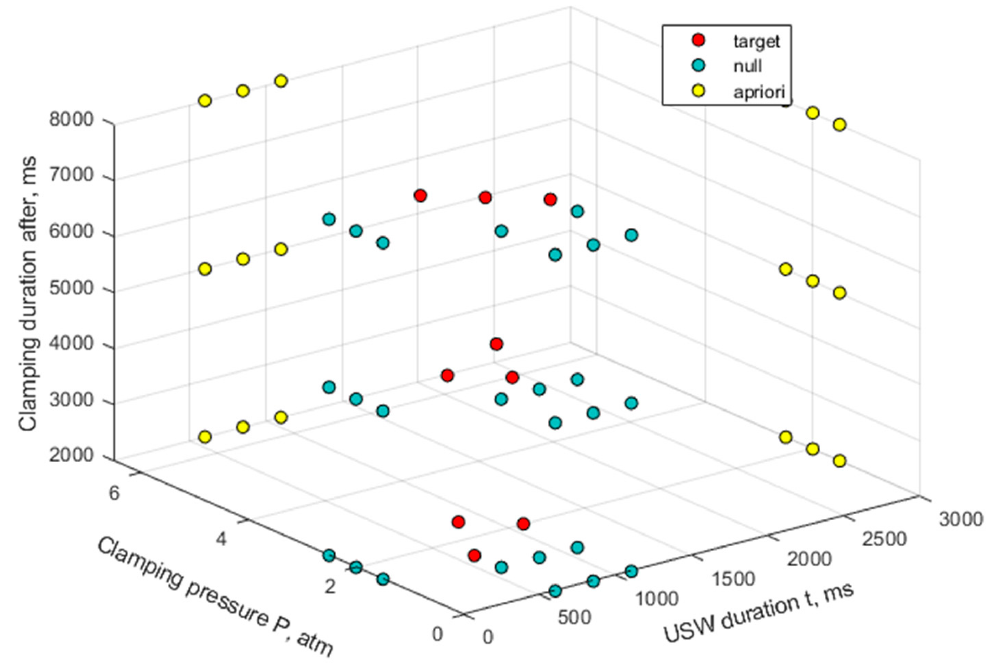
Figure 7. The distribution of the experimental parameters and selected priors for the USW results. The USW parameters used in the training sample: the experimental parameters; the param- eters under which lap joints are not formed; the parameters when the prepreg is fractured. Table 5. Threshold values of the optimal USW lap joint characteristics.